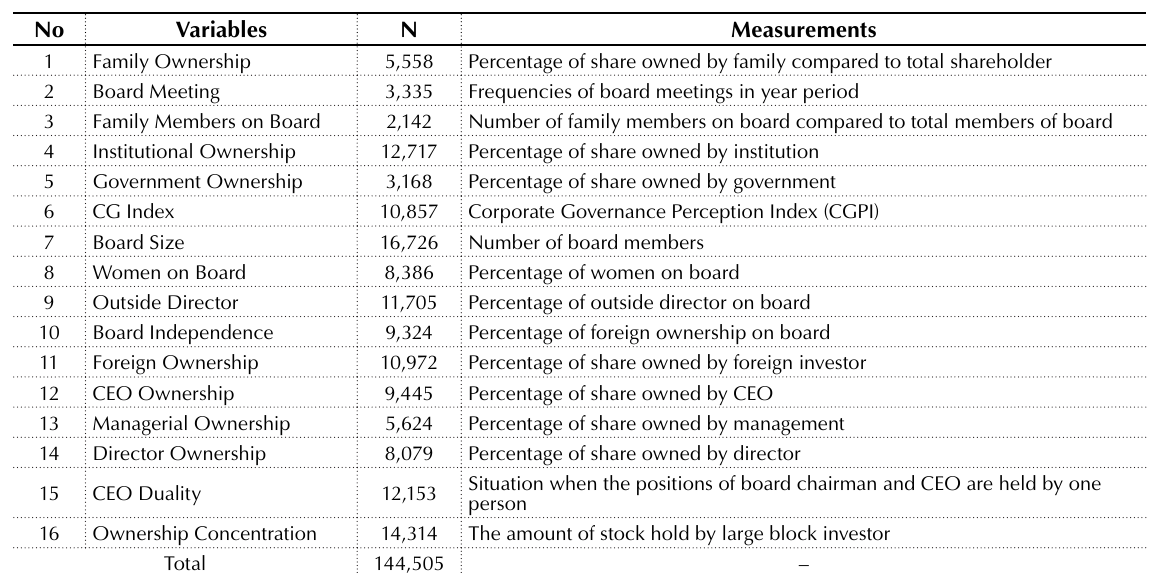
Table 2. Variables, observation, and